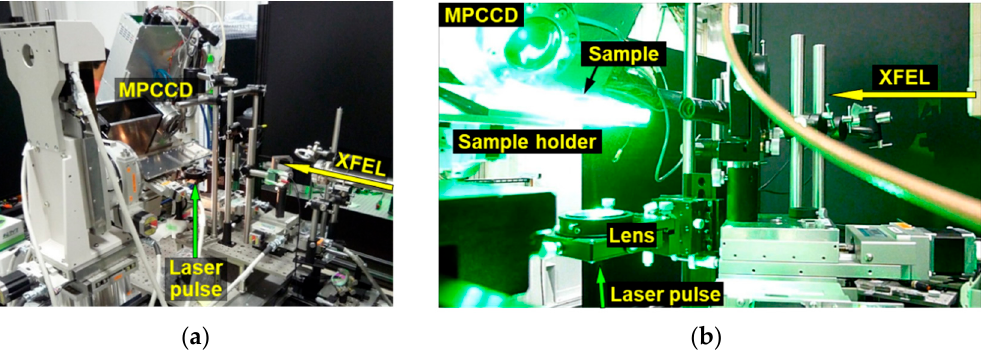
Figure 15. Configuration of the laser pump and the XFEL probe experiment performed at SACLA: ( a ) The setup around the sample and the diffractometer in preparation for ultra-fast X-ray diffraction (XRD); ( b ) at the moment of laser pulse irradiation.